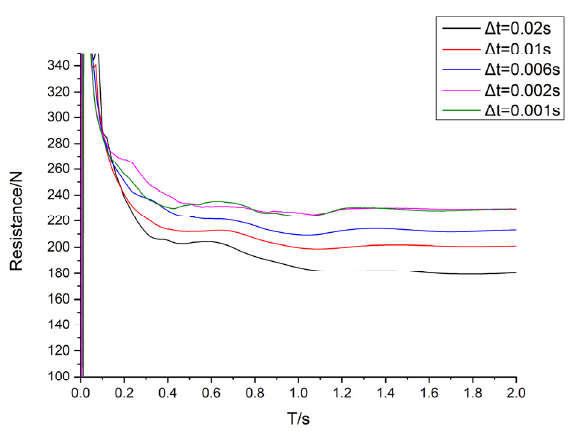
Figure 12. The resistance curve of different ∆ t.